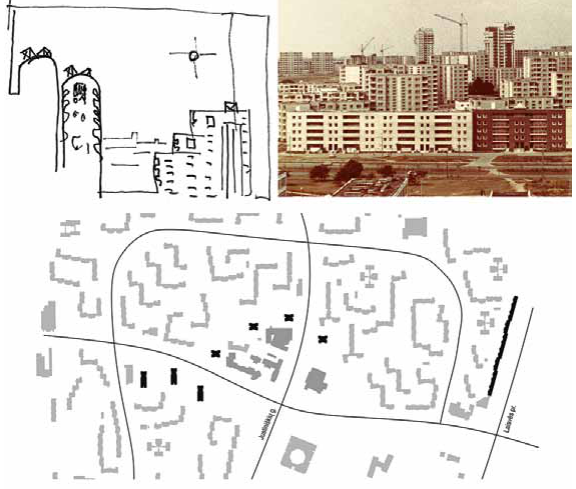
Fig. 7. Monolithic apartment buildings in justiniškės: view of the group, study, layout of the district